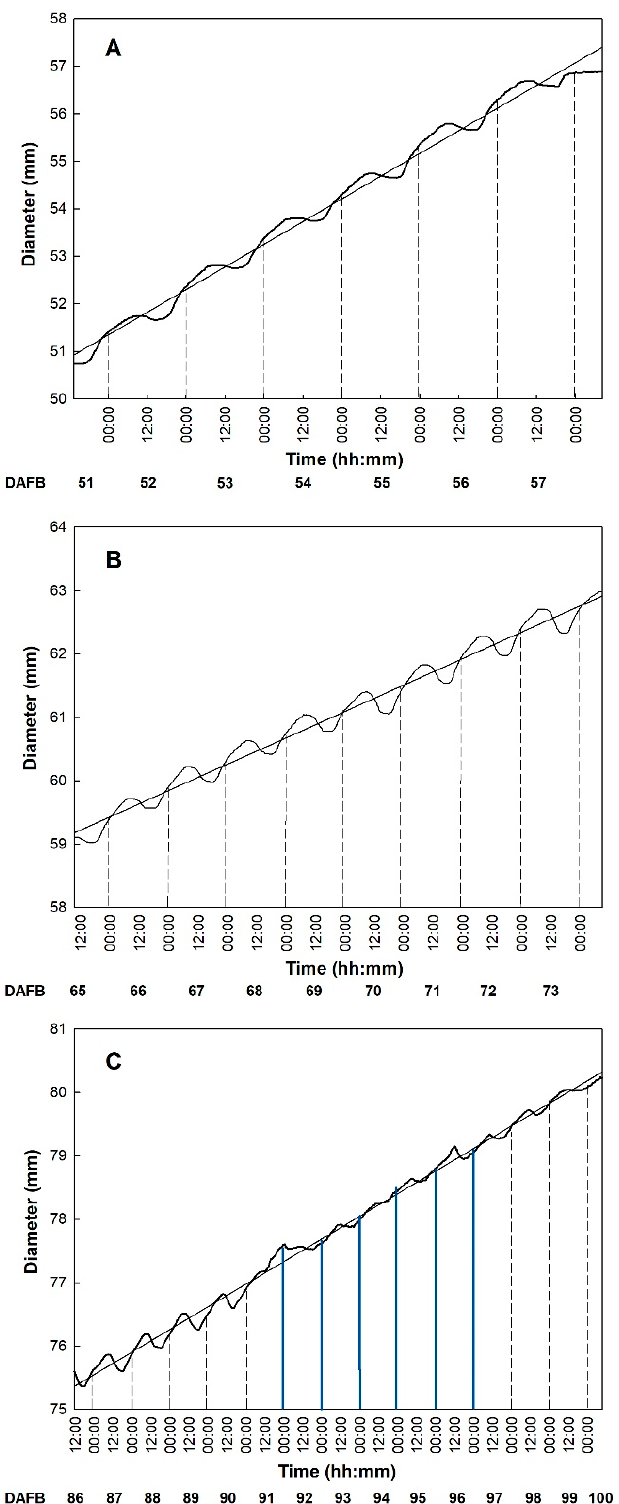
Figure 4. Trends of diametric growth of ‘Tommy Atkins’ mangos in the three observation periods monitored by fruit gauges every 15 min from 51 to 58 DAFB ( A ), from 65 to 74 DAFB ( B ), and from 86 to 100 DAFB ( C ). The blue lines indicate days of rainfall. Period I: Diameter = 1.010DAFB − 50,888; R 2 = 0.991; p < 0.001. Period II: Diameter = 0.417DAFB − 18,141; R 2 = 0.989; p < 0.001. Period ( III ): Diameter = 0.357DAFB – 15,513; R 2 = 0.995; p < 0.001.